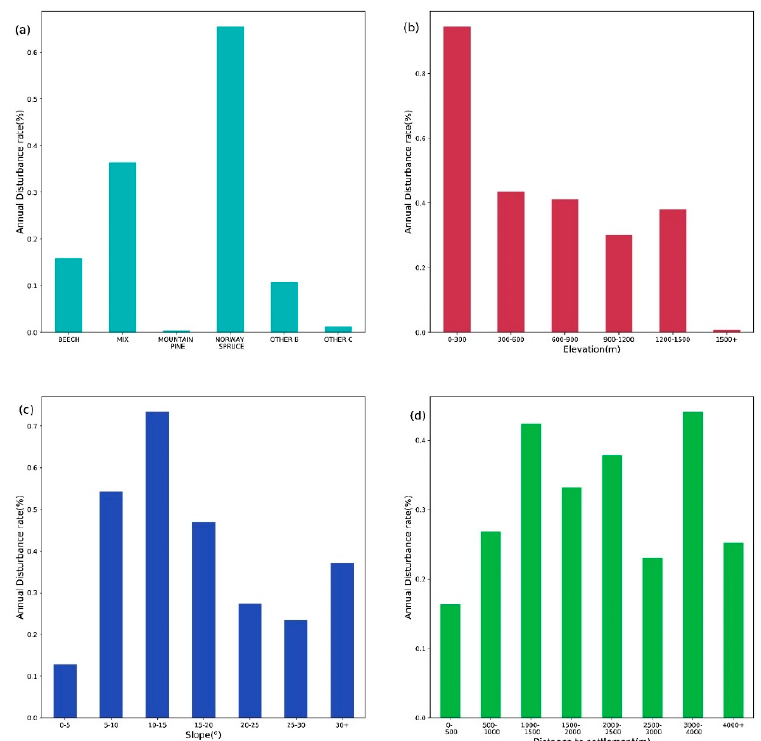
Figure 9. Mean annual disturbance from 2015–2019 of old-growth forest by ( a ) tree species, ( b ) elevation, ( c ) slope and ( d ) distance to settlement. Abbreviations as in Figure 1.